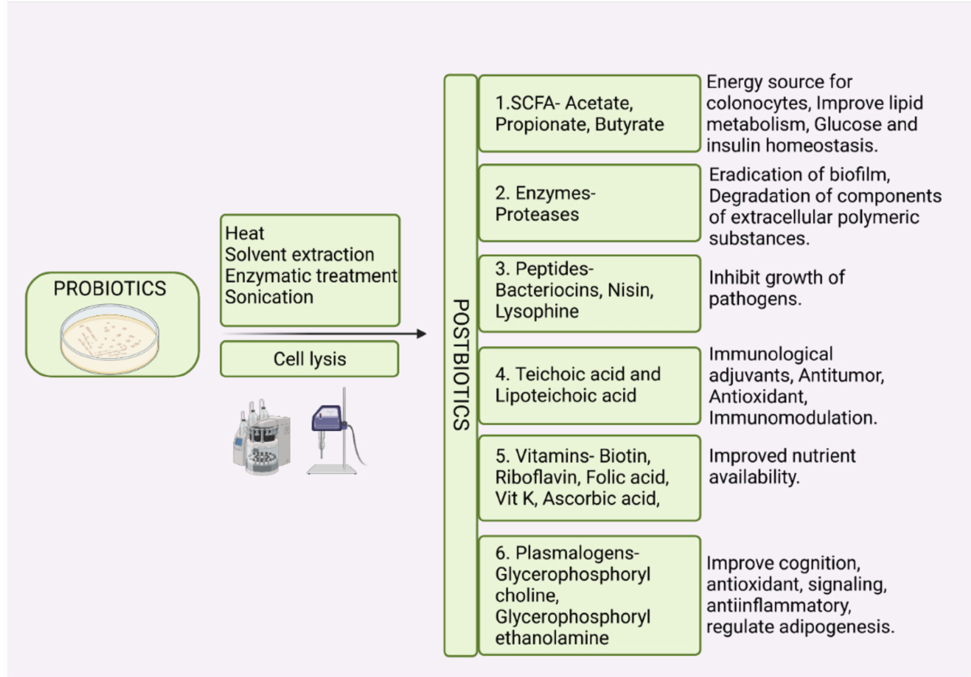
Figure 3. Postbiotics are soluble low molecular weight metabolites or cell lysis products derived from live or inactivated probiotic bacteria which when administered in adequate quantities demonstrate beneficial effects on host health. Created with Biorender.com (4 April